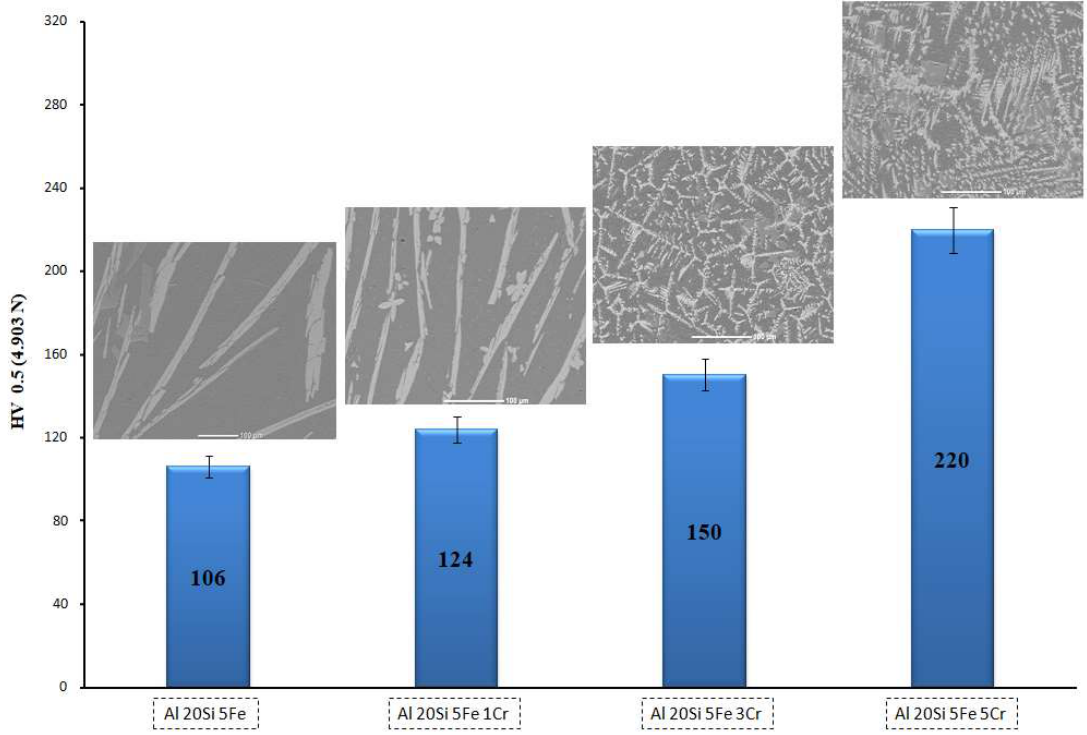
Figure 6. Microhardness of the Al–20Si–5Fe alloy with several Cr additions.